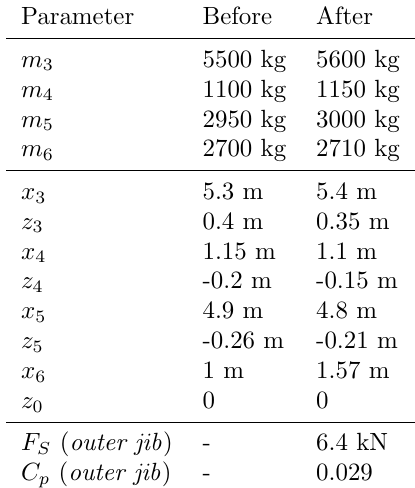
Table 7: Mechanical model parameters before and after parameter identification. Positions of COGs are according to Fig.